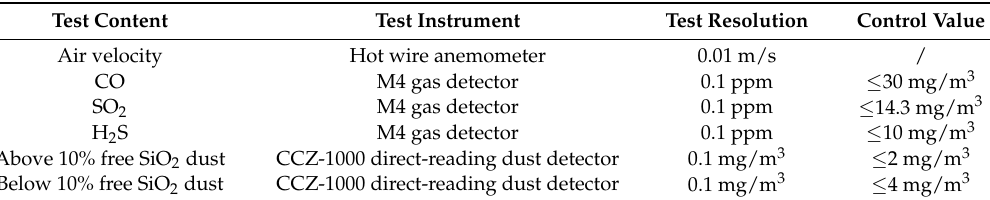
Table 1. Test content and related parameters.